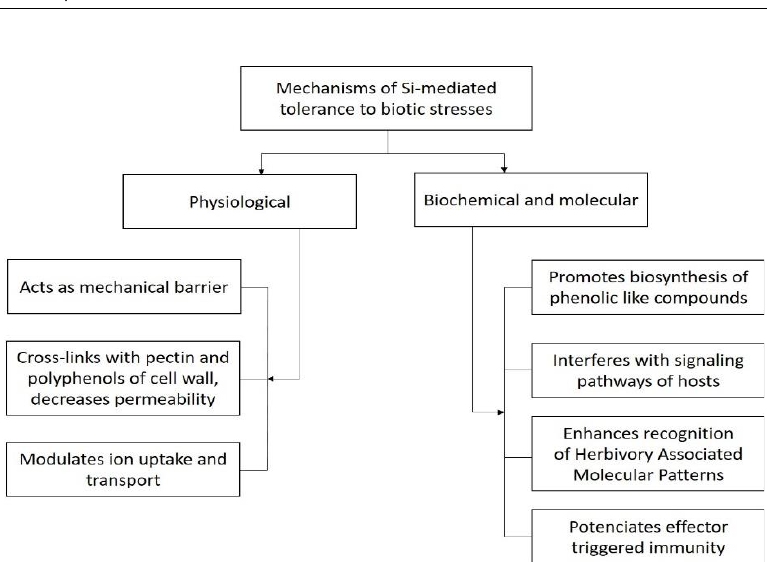
Figure 1. Mechanisms of Si mediated tolerance to biotic stress